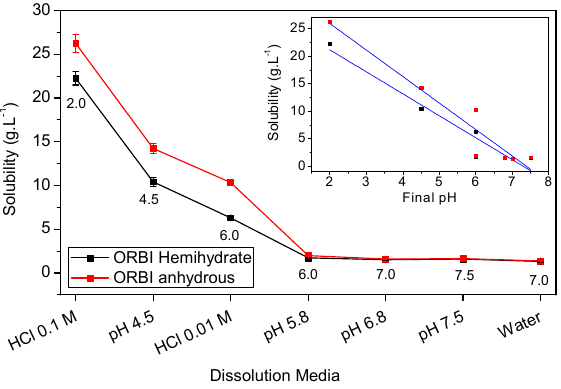
Figure 11. Equilibrium solubility values for ORBI anhydrous and hemihydrate forms at 25 °C, 150 rpm, 48 h. Error bars represent standard deviations (among 0.039 and 0.751 g ∙ L − 1 , n = 3). The inset shows the correlation including the linear regression (blue lines) between the equilibrium solubility values with the final pH of the different used media for the ORBI hemihydrate and anhydrous forms.